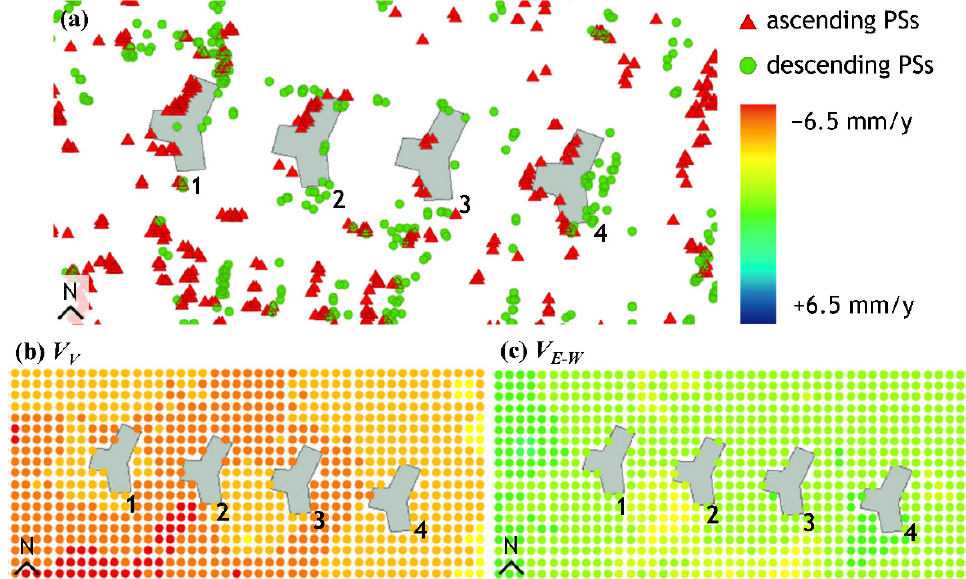
Figure 11. Torri Stellari area, considering PSs at the ground level: ( a ) ascending and descending PSs; mean velocity maps at the ground level along ( b ) vertical and ( c ) E–W direction.